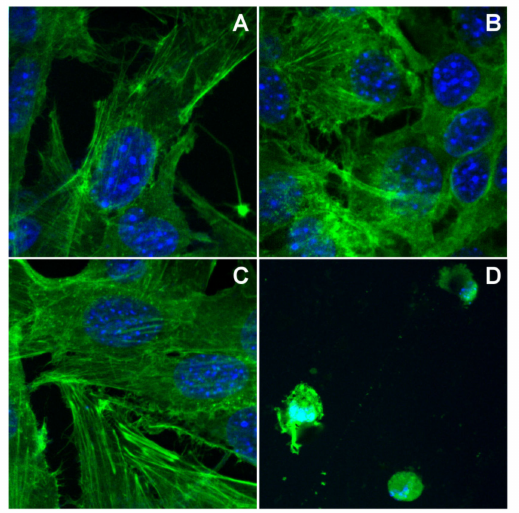
Figure 8. The cytoskeleton alteration for B16 cells: ( A ) control cells, ( B ) cells treated with pmtp, ( C ) cells treated with ( 1 ), ( D ) cells treated with ( 2 ).